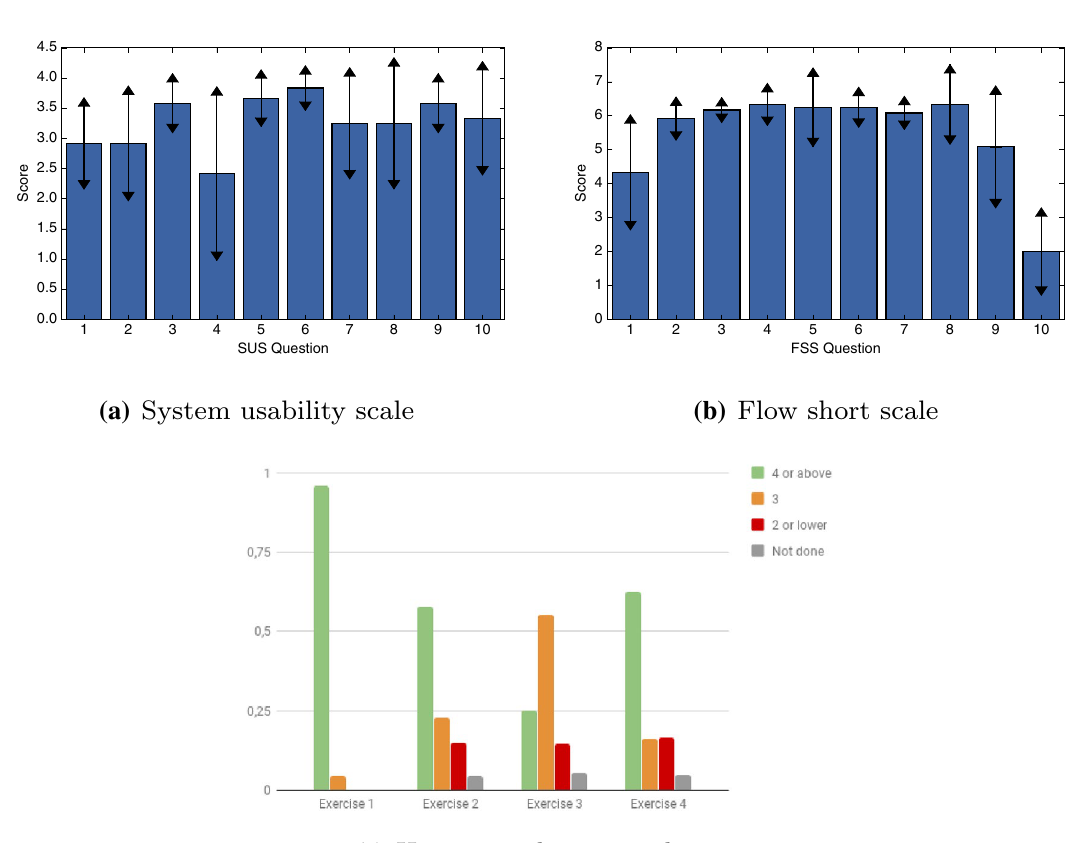
range. Graph c represents, for each different exercise, the percent- age of repetitions evaluated by the human evaluator with 4 or above, 3, 2 or lower, and not